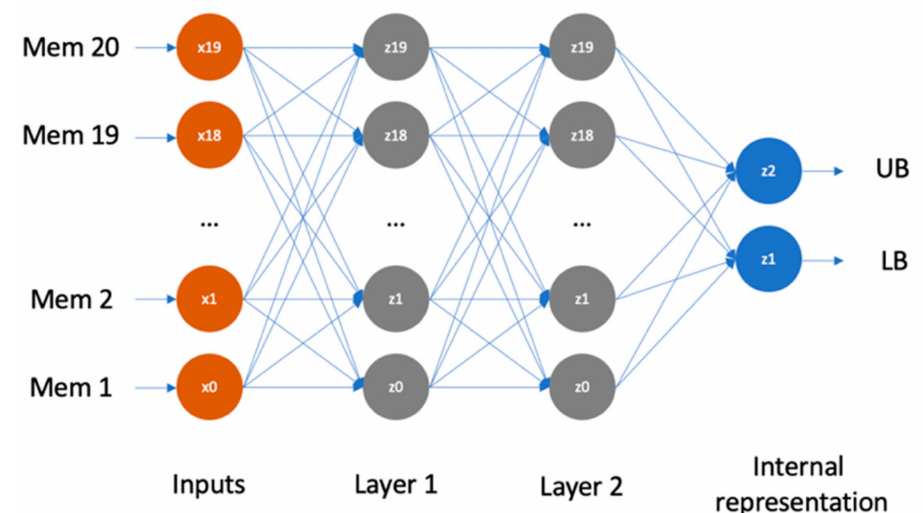
Figure 5. Construction of an autoencoder for preprocessing ensemble wind speeds.